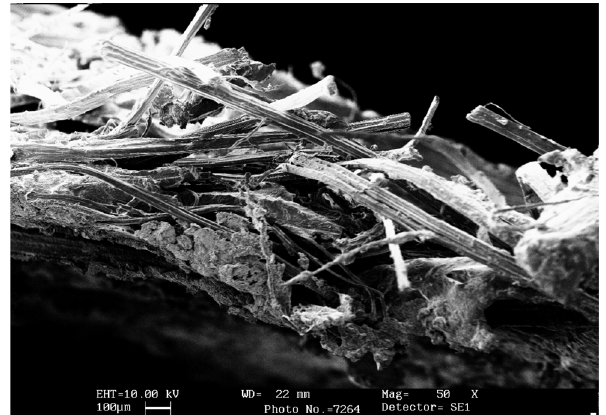
Figure 19: SEM for (10% jute fiber by weight) composite material with coating.